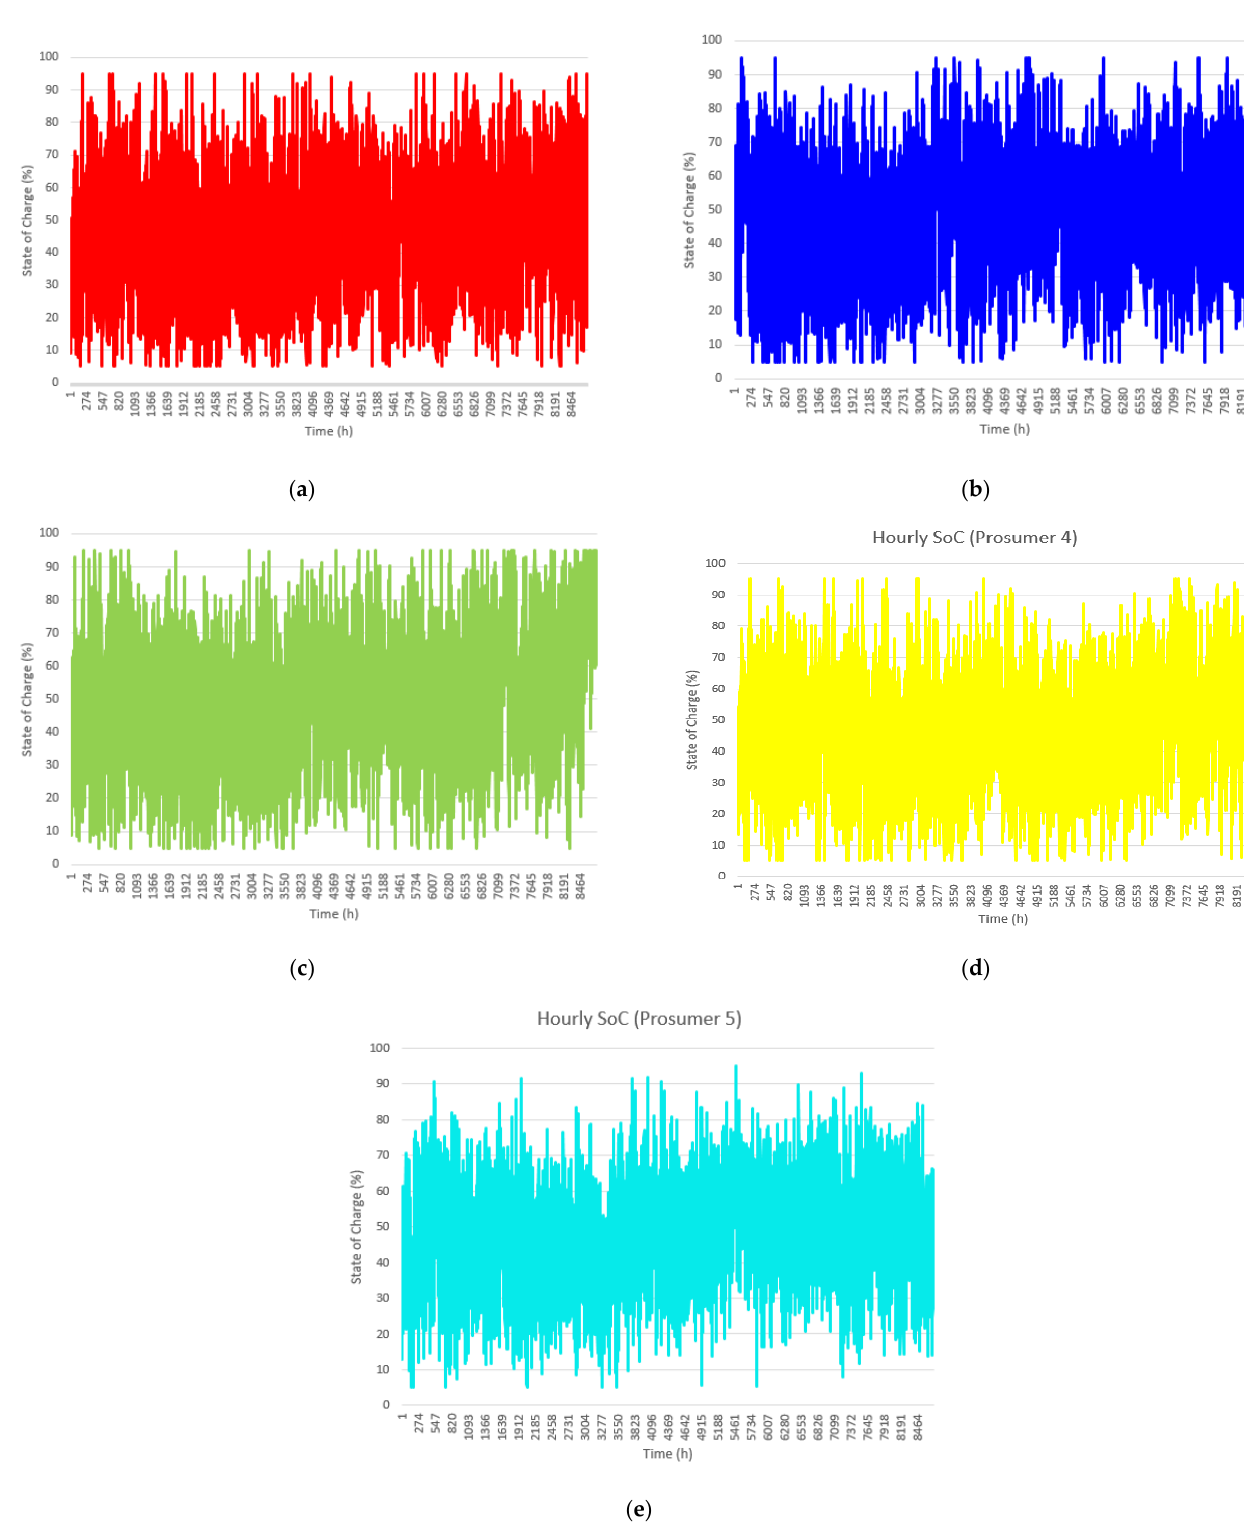
Figure 8. Annual evolution of individual SoCs. ( a ) SoC of User 1; ( b ) SoC of User 2; ( c ) SoC of User 3; ( d ) SoC of User 4; ( e ) SoC of User 5.